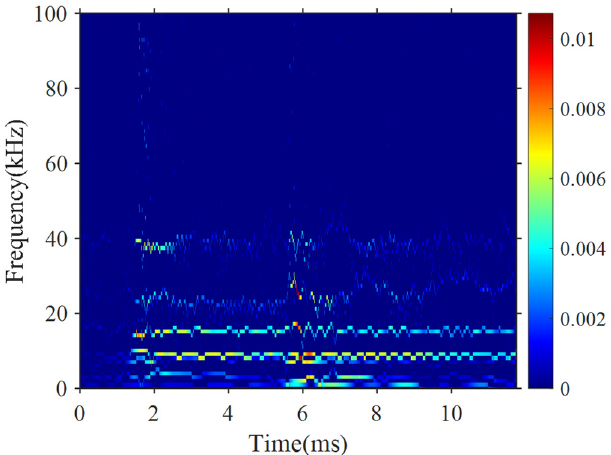
Figure 6. Time–frequency spectrum obtained by EWT–HT based on DFT and closing operation.